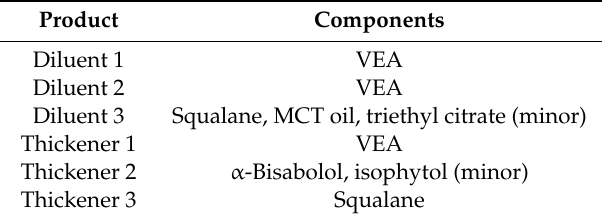
Table 3. Composition of six commercial vaporizer fluid diluents and